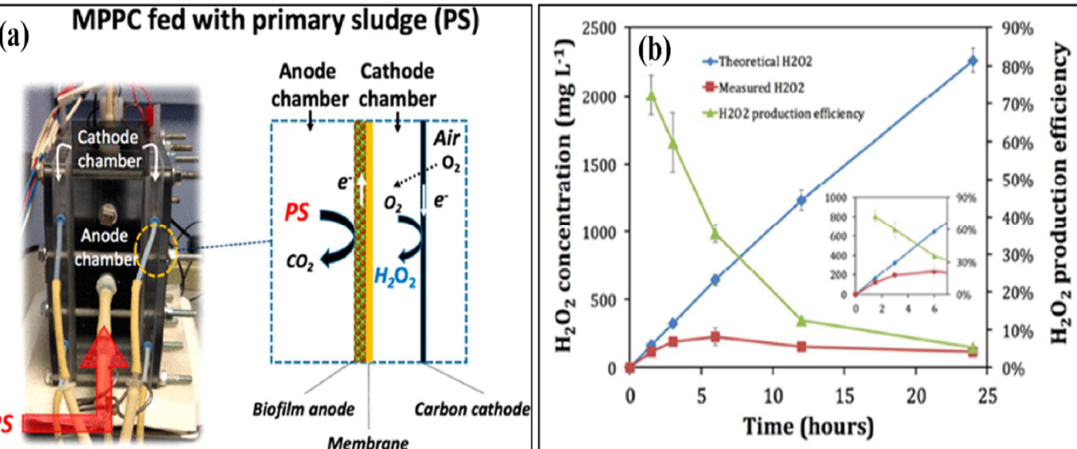
Figure 3. Results of a microbial peroxide producing cell’s cathode batch operation (MPPC). ( a ) Theoretical and measured H 2 O 2 concentrations that rely on a 100% transition from cumulative coulombs and a detection method, and H 2 O 2 productivity improvement (PPE) (N = 3 measurements). The inset shows the first six hours of operation in the MPPC. ( b ) Catholyte pH and alkalinity over a 24 h batch run. The results of a cathode batch operation of a microbial peroxide producing cell are given. (Reprinted with permission from [33]. Copyright 2019, American Chemical Society.)